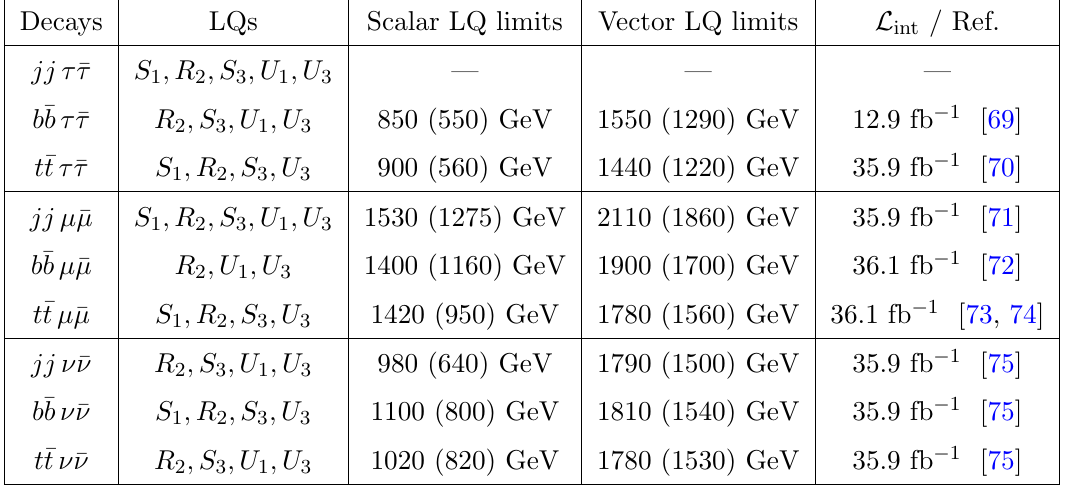
Table 1 . Summary of the current limits from LQ pair production searches at the LHC. In the (cid:12)rst column we give the searched (cid:12)nal states and in the second column the LQs for which this search is relevant. In the next two columns we present the current limits on the mass for scalar and vector LQs, respectively, for (cid:12) = 1 ( (cid:12) = 0 : 5). In the last column we display the value of the LHC luminosity for each search along with the experimental references. Note that \ j " denotes any jet originating from a charm or a strange quark. Entries marked with \ (cid:0) " indicate that no recast or search in this channel has been performed up to this